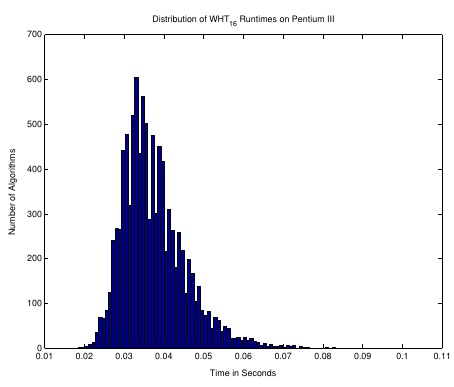
Fig. 2: Performance histogram on the Pentium